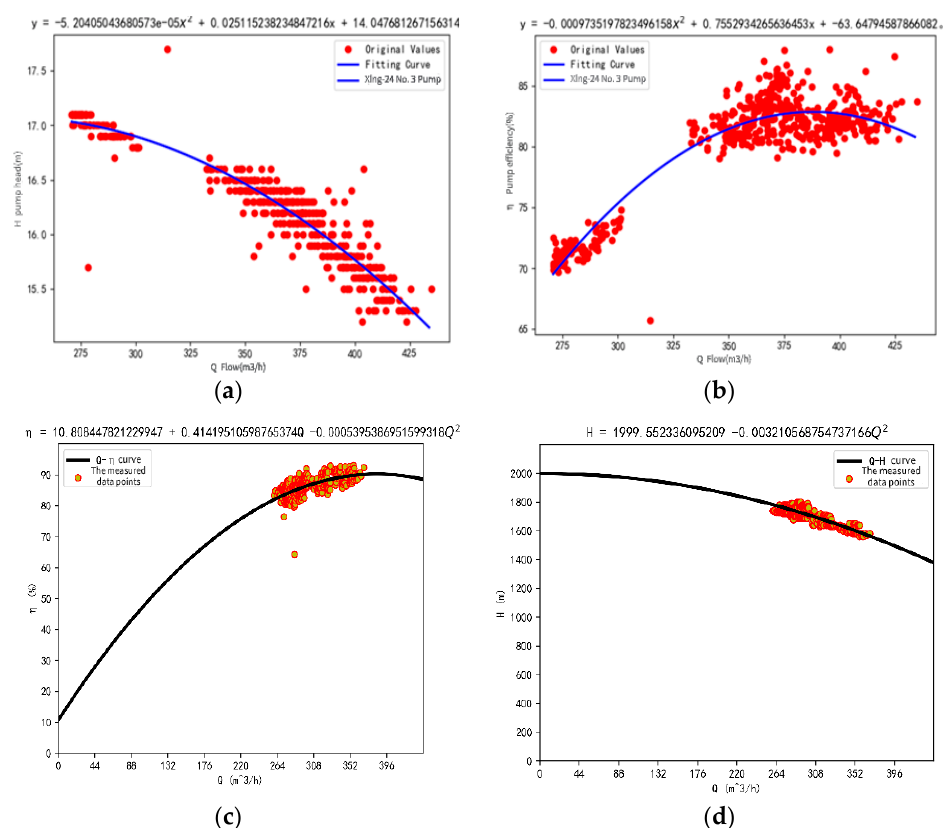
Figure 12. Big data fitting scatter plot. ( a ) H-Q curve of 3 pump of Xing-24 station; ( b ) η -Q curve of 3 pump of Xing-24 station; ( c ) η -Q curve of 1 pump of Xing-7 station; ( d ) H-Q curve of 1 pump of Xing-7 station.